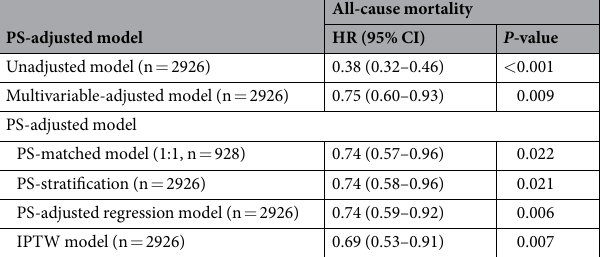
Table 4. Association between treatment with phosphate-binders and all-cause mortality. The HR was estimated using Cox proportional hazard model. In the multivariable model, age, sex, presence of diabetes mellitus and comorbidity, dialysis history, dialysis time per session, Kt/V for urea, normalized protein catabolic rate, body mass index, cardiothoracic ratio, systolic blood pressure, blood hemoglobin level, serum levels of urea nitrogen, creatinine, albumin, total cholesterol, C-reactive protein, corrected calcium, phosphate, alkaline phosphatase, and parathyroid hormone, and use of erythrocyte stimulating agents, anti-hypertensives, and vitamin D receptor activators were included. PS was created by logistic regression analysis using all the parameters listed here. A two-tailed P -value less than 0.05 was considered statistically significant. Abbreviations: CI, confidence interval; HR, hazard ratio; IPTW, inverse probability of treatment weighting; PS, propensity